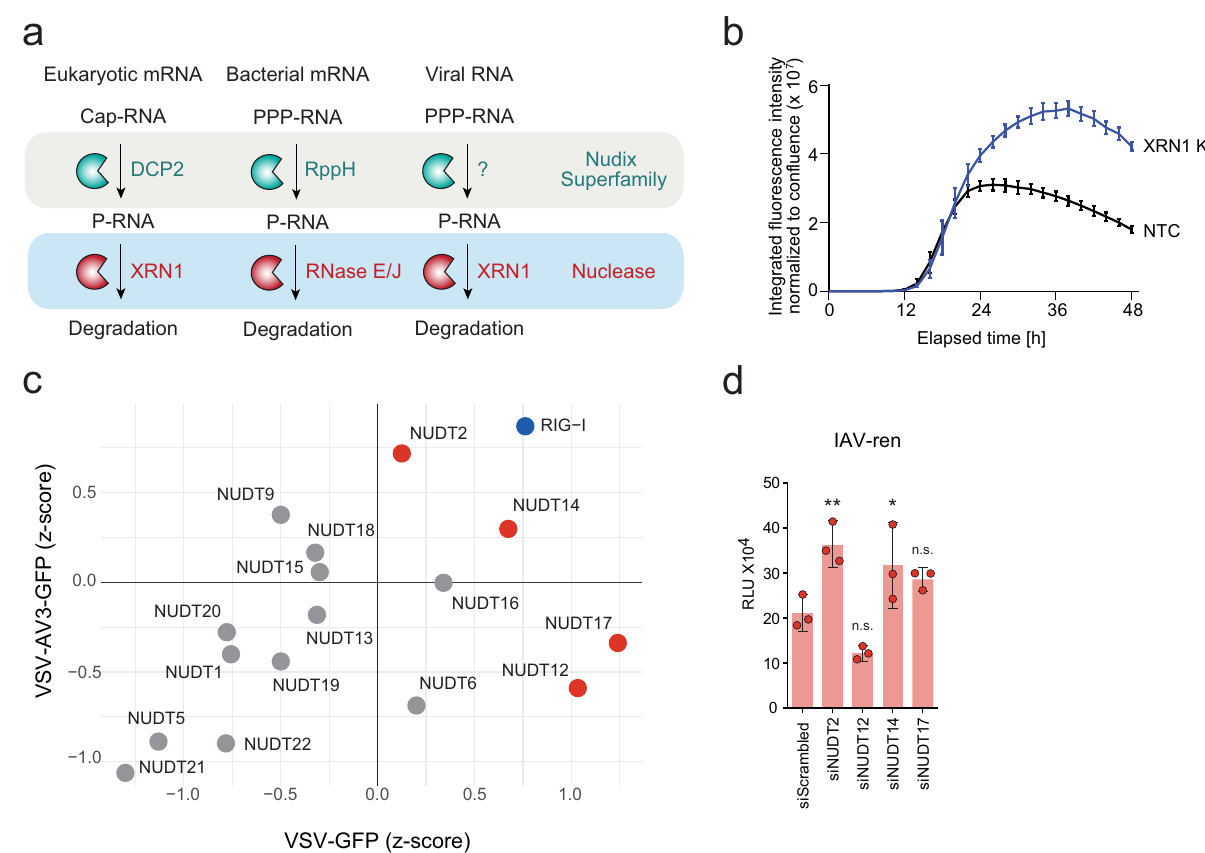
Fig. 1 In fl uence of Nudix depletion on virus growth. a Schematic representation of processes involved in 5 ′ -to-3 ′ RNA degradation. Eukaryotic and bacterial triphosphorylated messenger (m)RNA are processed by proteins DCP2 and RppH, respectively, to generate monophosphorylated substrates for the 5 ′ -3 ′ exonuclease XRN1, RNase E or RNase J. We hypothesize that a mammalian Nudix hydrolase could prepare viral RNA for degradation by removing pyrophosphate groups. b Hep3B cells with a CRISPR/Cas9-mediated KO of XRN1 or Hep3B cells transduced with a non-targeting-control vector (NTC) were infected with VSV-GFP at MOI 0.01 for 48 h. GFP expression was continuously quanti fi ed by live-cell microscopy. The data points are displayed as the mean of fi ve technical replicates ± SD. One representative experiment of three is shown. c HeLa cells transfected with siRNA pools targeting the indicated Nudix gene for 48 h were infected with VSV-GFP ( x -axis) or VSV-AV3-GFP ( y -axis). Twenty-four hours after infection, GFP expression was analyzed by fl uorometric analysis. The displayed z -scores were calculated from three independent reactions. d HeLa cells were treated with siRNA pools for 48 h targeting the transcript of NUDT2 , NUDT12 , NUDT14 , NUDT17 , or non-targeting siRNA control (siScrambled) and infected with In fl uenza A reporter virus expressing the renilla luciferase (IAV-ren) at MOI 1. Forty-eight hours post-infection, renilla luciferase activity was analyzed. The means of three biological replicates ± SD are shown; ** p = 0.004, * p = 0.03 as analyzed by two-way analysis of variance (ANOVA) statistics. RLU relative light units. n.s. not signi fi